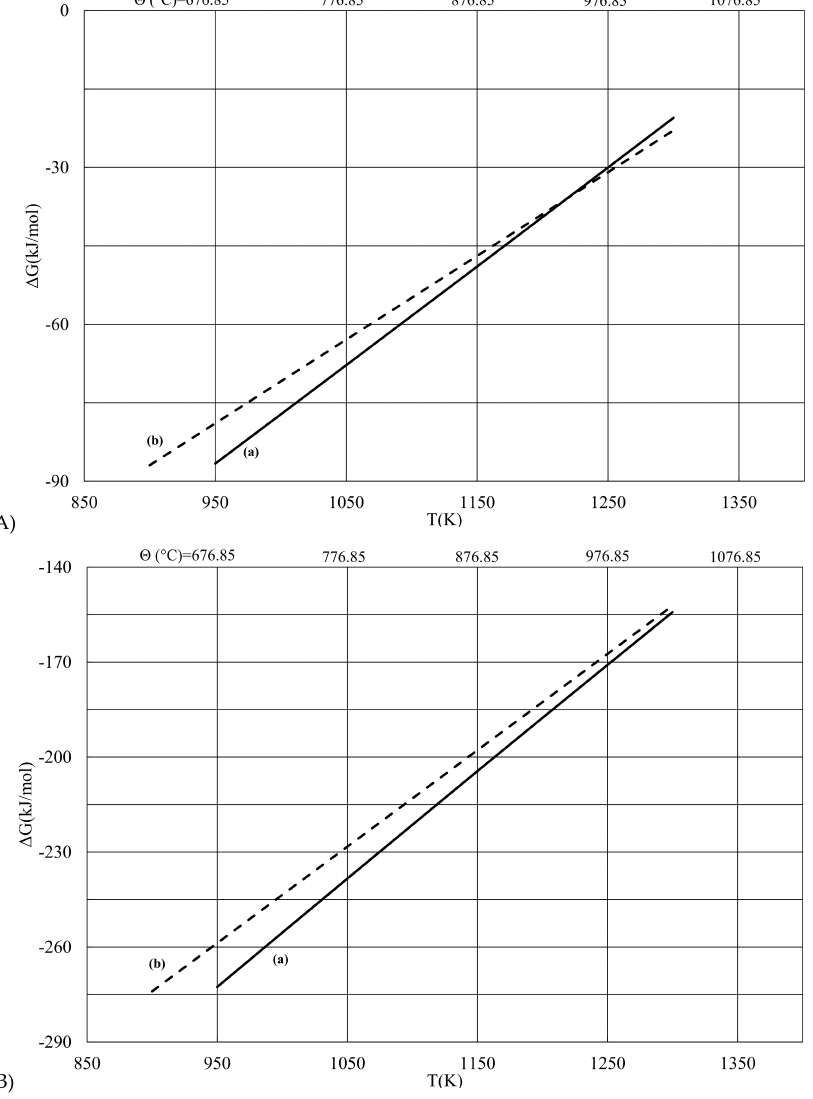
Figure 1. Comparison of the calculated Gibbs free energy ( Δ G) against temperature, for two reactions. ( A ) 3Rh ( s ) + 2S 2 ( g ) = Rh 3 S 4 ( s ) in this study with values obtained by previous authors [25]. Data for Line (a) from Table 2; data for Line (b): Δ Gf ( J·mol − 1 ) = − 548026 + 304.5 × T ( K ) from [25]. ( B ) 4Rh 3 S 4 ( s ) + S 2 ( g ) = 6Rh 2 S 3 ( s ) in this study with values obtained by previous authors [25]. Data for Line (a) from Table 3; data for Line (b): Δ Gf ( J·mol − 1 ) = − 230957 + 160.03 × T ( K )from [25]. Table 3. Comparison between Δ G f values of (a) this study and (b) [25] for the reaction: